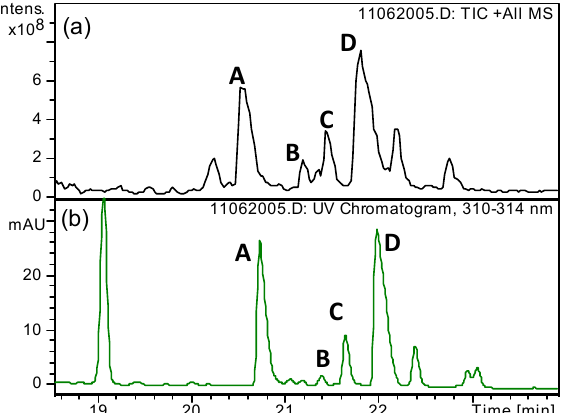
Figure 4. Representative high-performance liquid chromatography/mass spectrometry (HPLC/MS) analysis of a liver extract 1 h after administration of An2-PAPTP. ( a ) Total ion current chromatogram; ( b ) UV chromatogram, 310–314 nm. Identification of the main HPLC peaks: A = PAPTPL-IT ( m / z = 1061.6), B = PAPTPL ( m / z = 803.4), C = PAPTPL-I ( m / z = 960.5), D = PAPTPL-ITF ( m / z = 1208.7).